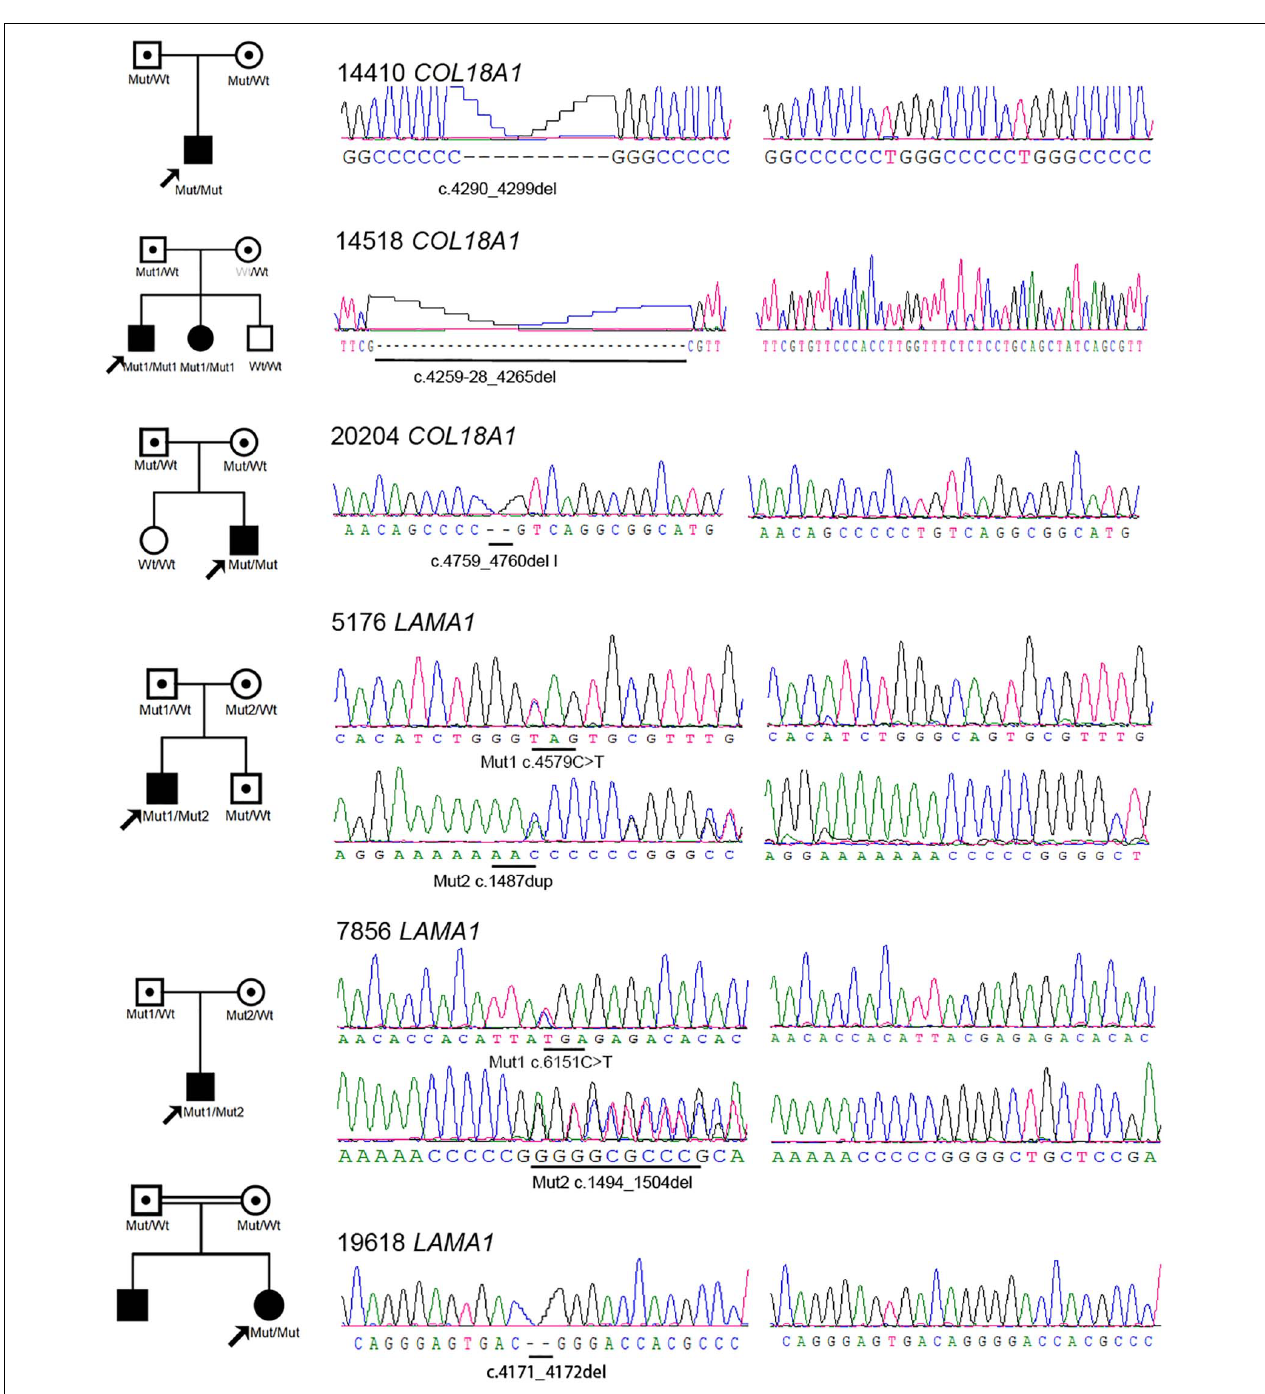
FIGURE 2 | Pedigrees and sequences of eight novel loss-of-function mutations in the COL18A1 and LAMA1 genes. The genotypes of all probands and available family members are shown below each individual. The black symbols represent the affected individuals. The white symbols with black points represent carriers. Mut, mutation; wt, wild type. One allele of the wt in the mother of 14518 is marked as gray because it is a pseudo-wild type caused by gross deletion cross missing by Sanger sequencing.